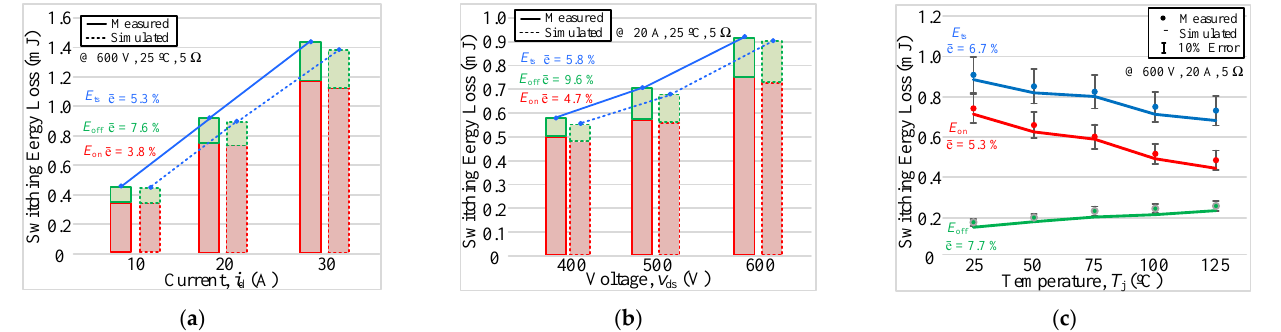
Figure 16. Power losses of SiC MOSFET under different values of ( a ) current; ( b ) voltage; ( c ) temperature.